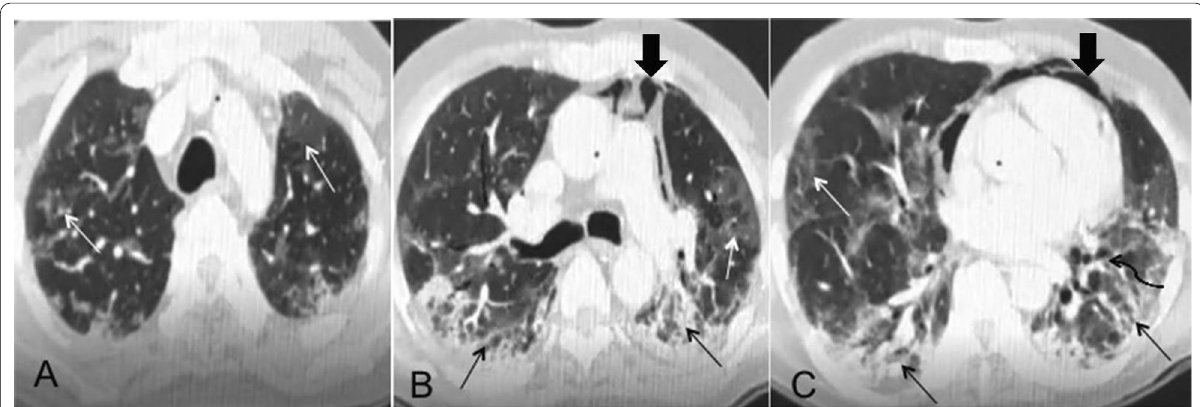
Fig. 1 Reticular predominant changes. Bilateral lungs show predominant reticular changes with interlobular septal thickening, fibrotic bands, and subpleural fibrotic changes similar to that observed in usual interstitial pneumonia (black arrows). Also notes are patchy areas of ground-glass opacities (white arrows) in bilateral lungs and tractional bronchiectasis (black curved arrow). Pneumomediastinum is also seen (solid black arrow)